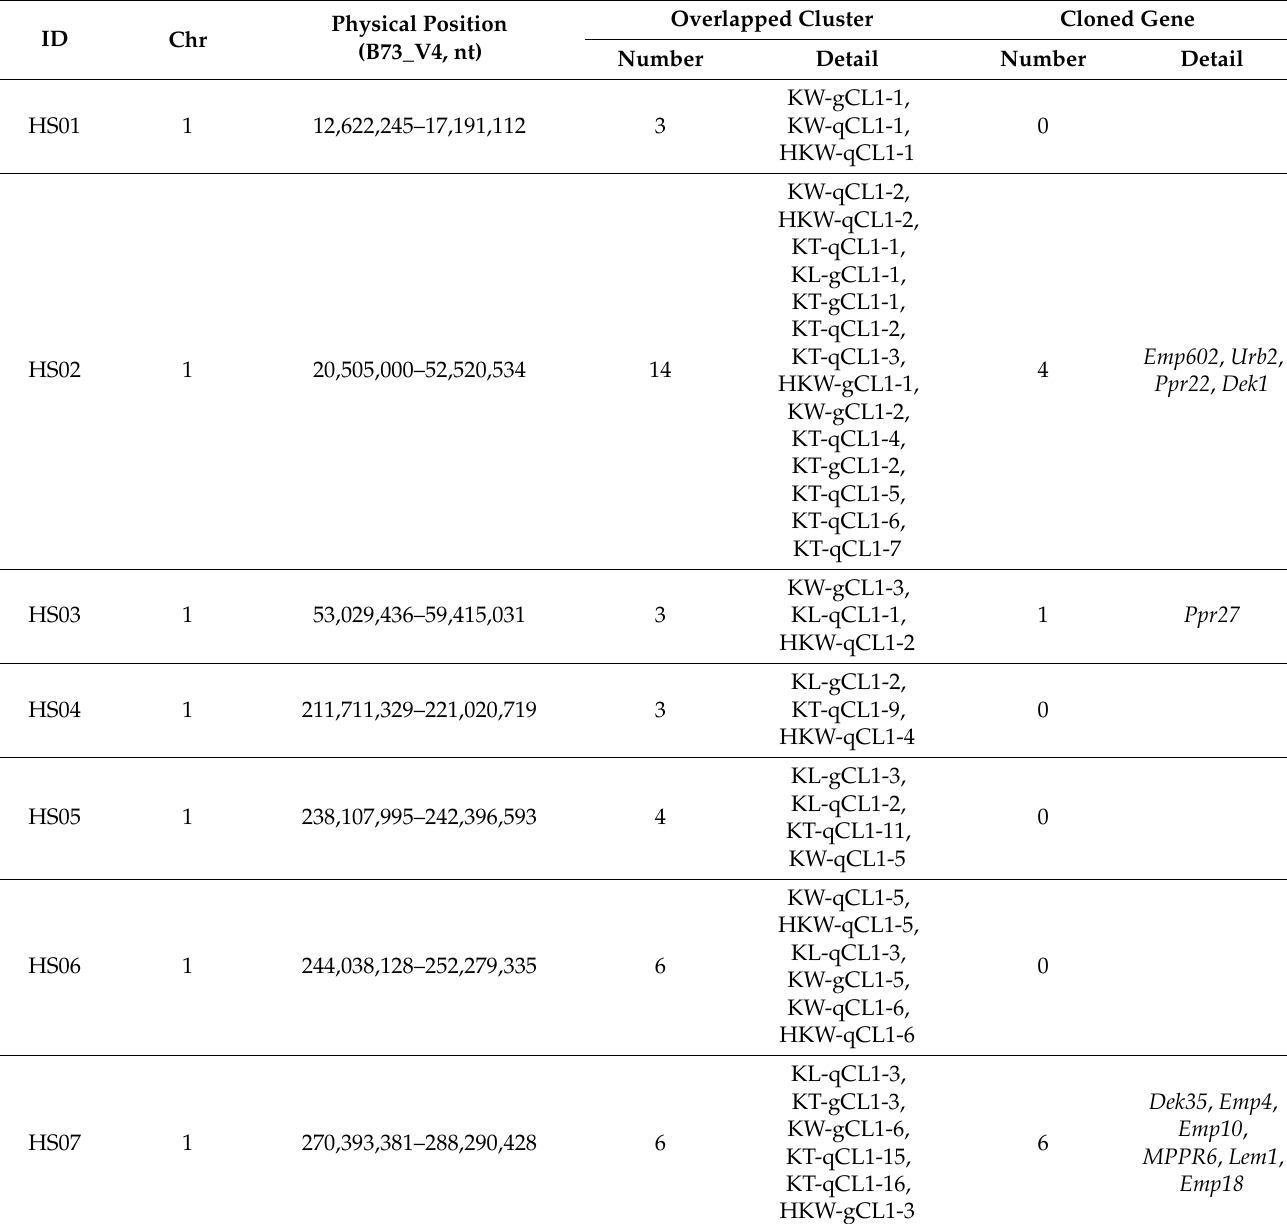
Table 2. Summary of QTL/QTN hotspots associated with kernel size-related traits in